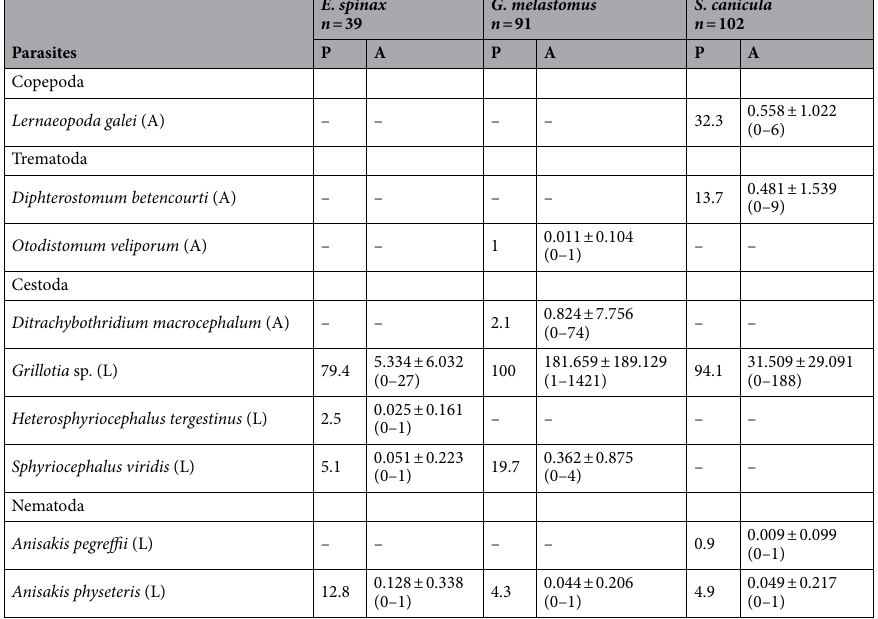
Table 2. Prevalence (P, expressed in percentage) and mean abundance (A ± standard deviation with ranges in brackets) of parasites found in E. spinax , G. melastomus , and S. canicula from the Gulf of Naples. Abbreviations: (A), adult parasites; (L), larval